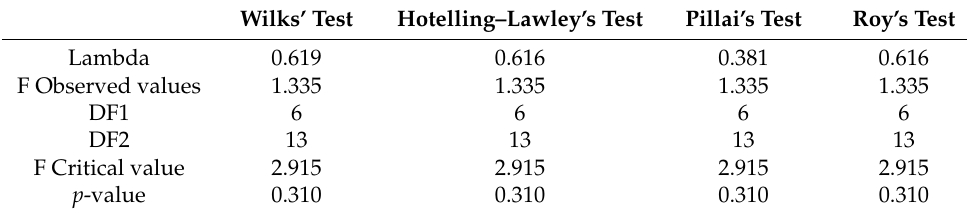
Table 2. MANOVA results of the coatings with crosslinker.